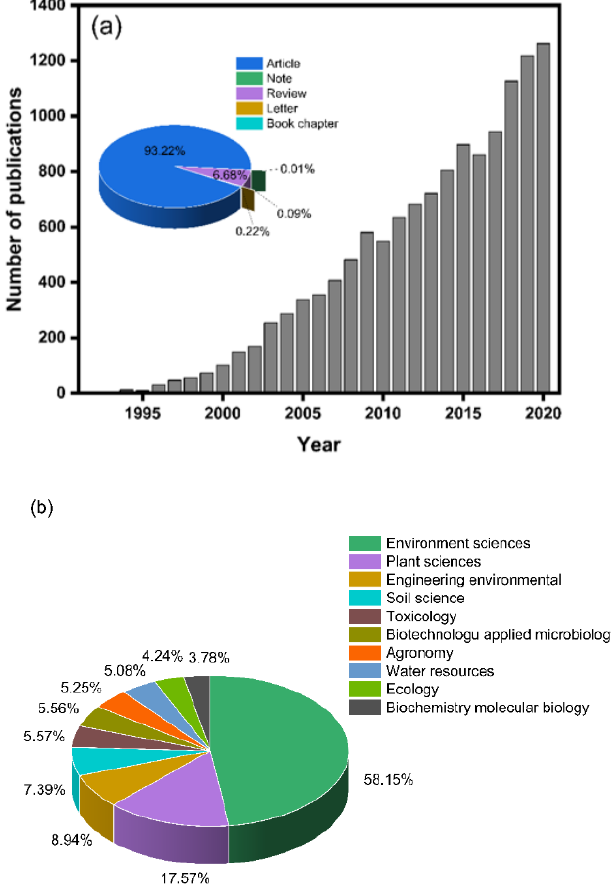
Figure 1. ( a ) Annual publications on the topic of hyperaccumulators remediation of potential toxic element (PTE) pollution based on data from Science Citation Index Expanded (Sci-Expanded) database of the Web of Science Core Collection (WoSCC) and document types; ( b ) percentages of publications for Web of Science